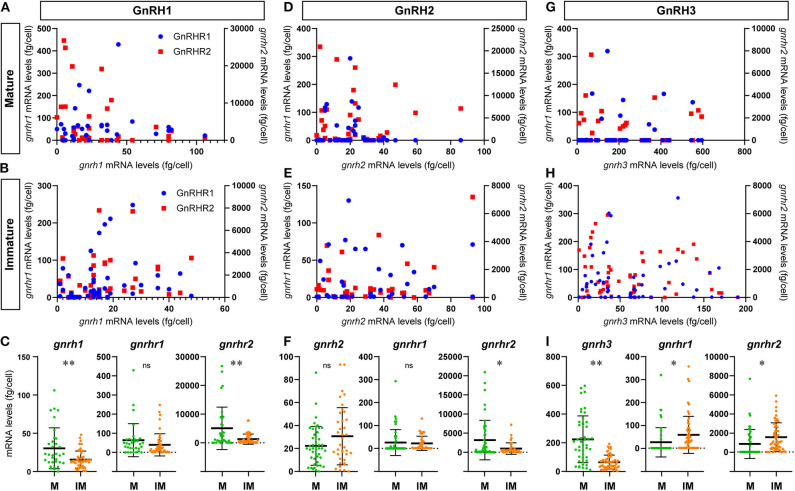
Graphs showing the distribution of GnRH receptor types mRNA transcripts in microdissected single GnRH-GAP neurons in mature and immature males. In the scatter blot diagrams (A,B,D,E,G,H), the x-axis represents the levels of each GnRH mRNAs in GnRH-GAP cell soma, while the 1st (left side) y-axis represents gnrhr1 mRNA levels and 2nd (right side) y-axis represents gnrhr2 mRNA levels in each GnRH-GAP cell soma. Red dots represent gnrhr1 and blue dots represent gnrhr2 mRNA levels. Column scatter blot diagrams in below (C,F,I) show the mRNA levels of GnRH (gnrh1, gnrh2, and gnrh3) and GnRH receptor types per GnRH-GAP cell soma in mature (M, green) and immature (IM, orange) males. *P < 0.05; **P < 0.001; ns, non-significant.